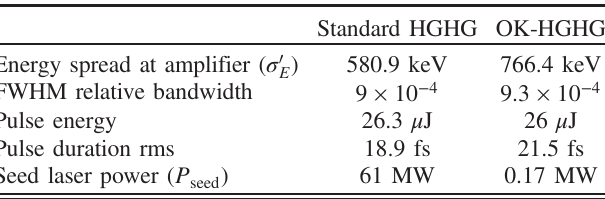
TABLE III. Comparison of simulation results between a stan- dard HGHG and an OK-HGHG setup. The output wavelength is 20 nm and results as the 15th harmonic of a 300 nm seed laser. The energy spread is calculated upstream from the amplifier.